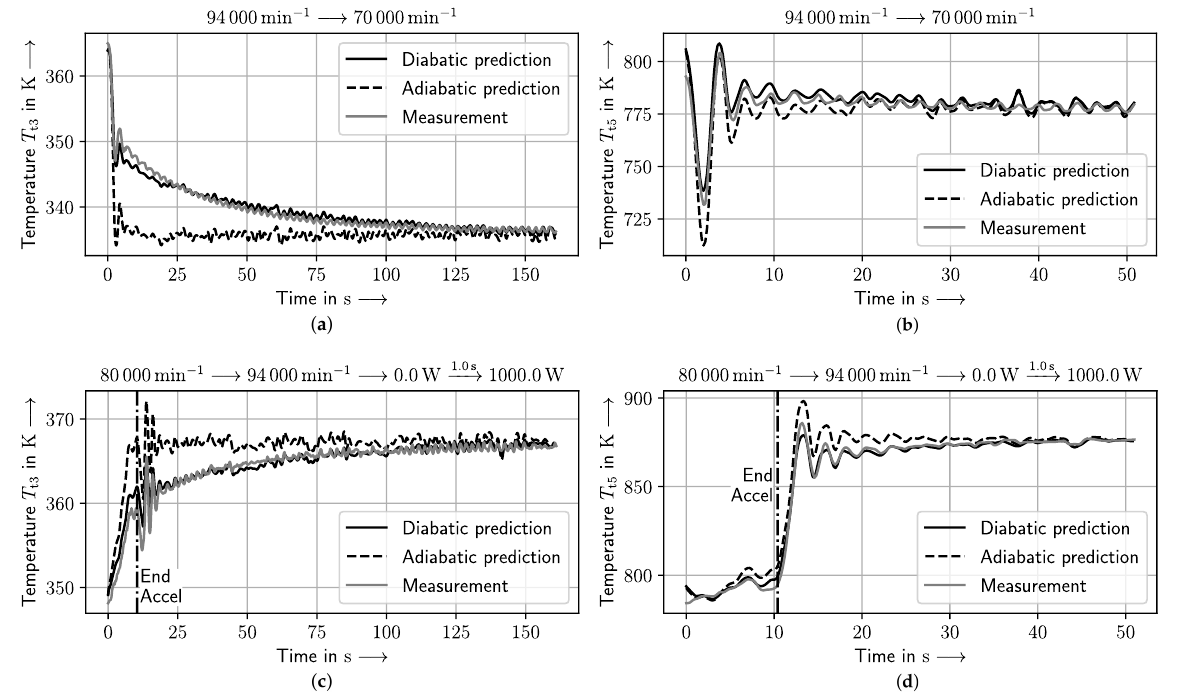
Figure 13. Comparison of measurement, adiabatic prediction (performance model without the neural network to model heat transfer), and diabatic prediction (same performance model with the neural network). Predictions are corrected for deviations in the stationary performance model; see Equation (33). ( a ) Compressor exit temperature, deceleration, ( b ) turbine exit temperature, deceleration, ( c ) compressor exit temperature, acceleration (accel), and loading, and ( d ) turbine exit temperature, acceleration (accel), and